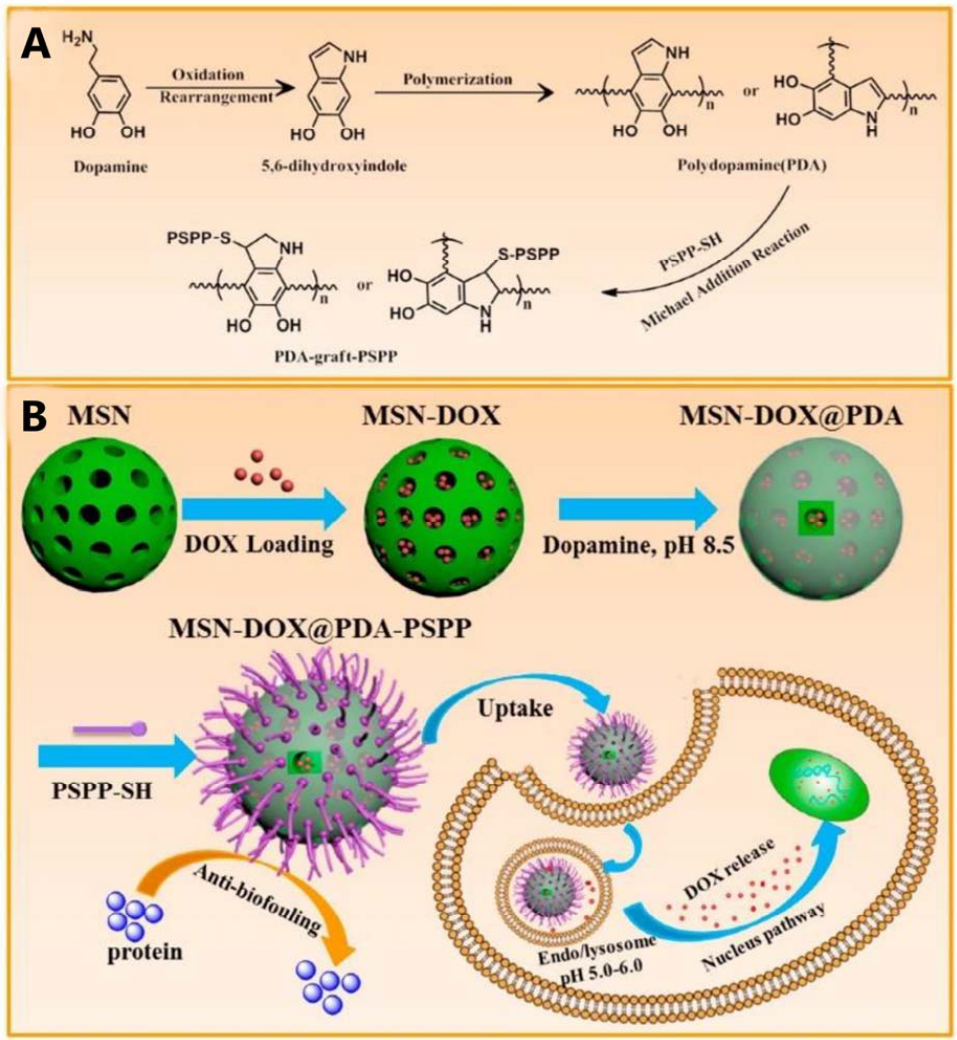
Figure 15. ( A ) Oxidative polymerization of dopamine and conjugation pf PSPP-SH with poly- dopamine (PDA) through Michael addition reaction; ( B ) Schematic illustration for the formation process of mesoporous silica nanoparticles-doxorubicin@PDA-PSPP (MSN-DOX@PDA-PSPP), the cellular uptake and drug release process of MSN-DOX@PDA-PSPP. Reproduced with permission from ref. [159] under Creative Commons Attribution (CC-BY)